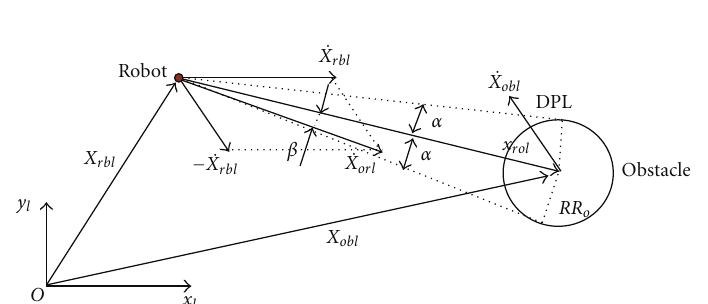
Figure 7: Expanded obstacle.